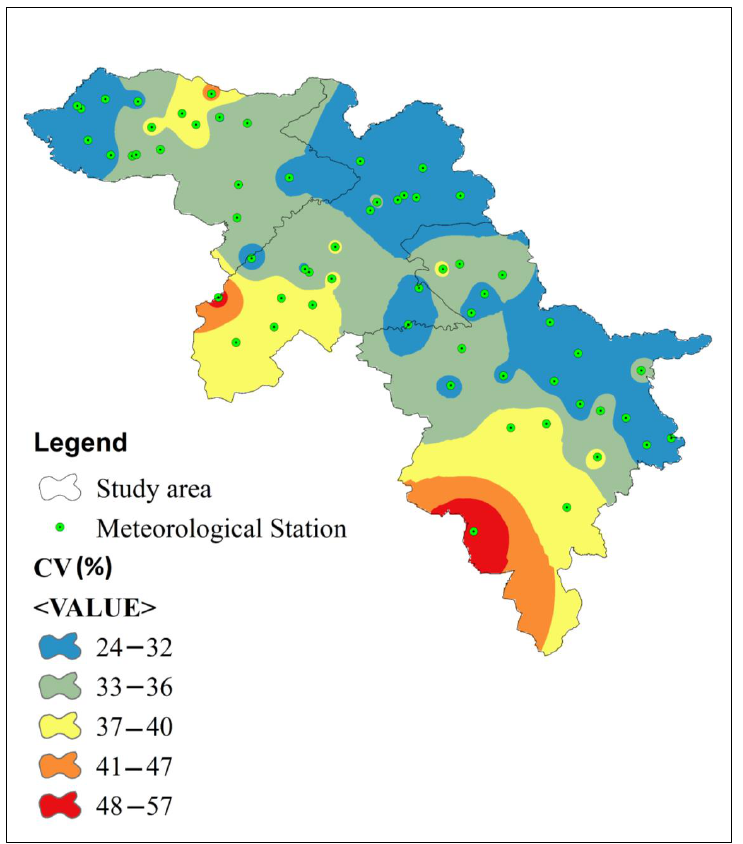
Figure A2. The coefficient of variation (CV%) map of annual precipitation for 60 selected meteorological stations across the KRI.